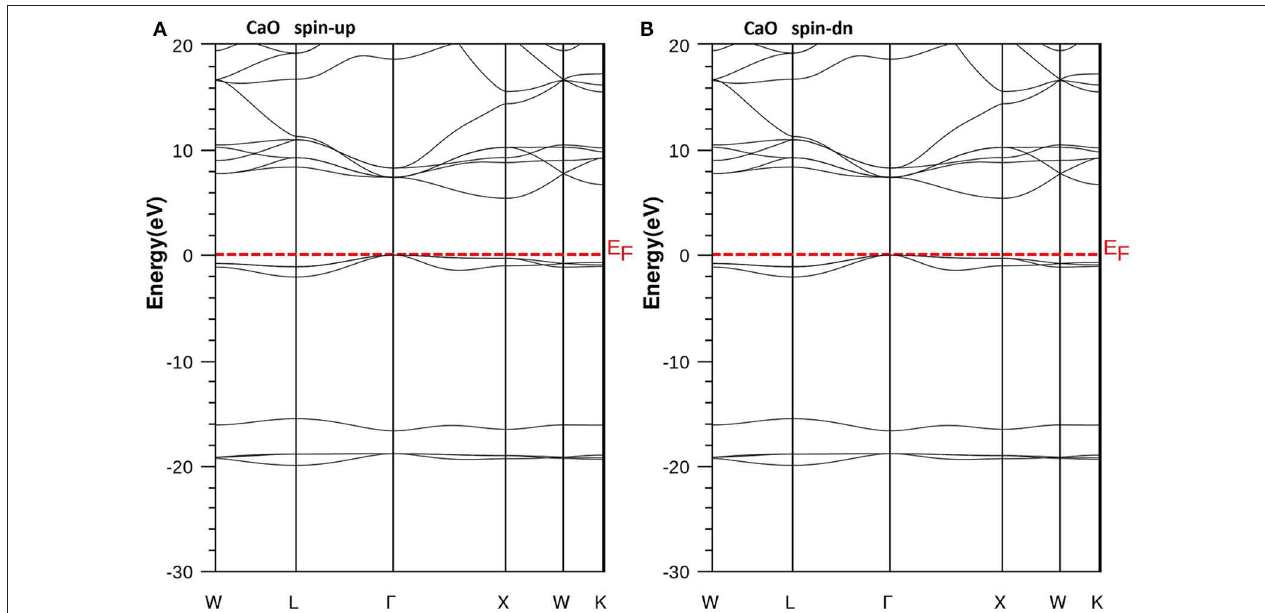
FIGURE 4 | Band structures of CaO. (A) Majority spins ( up ) and (B) minority spins ( dn ). The Fermi level is set to zero ( horizontal dotted line ).